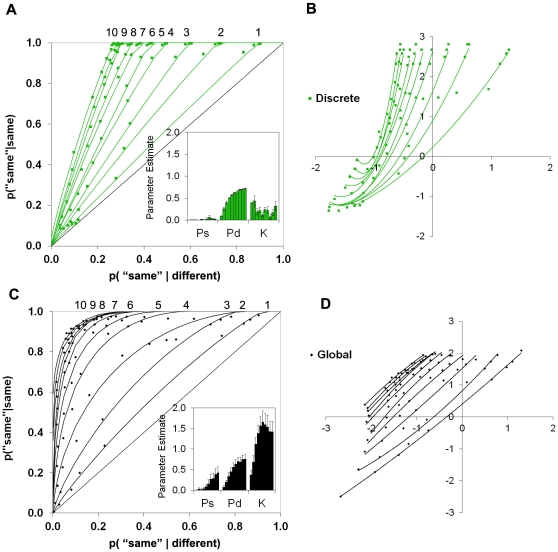
ROCs and zROCs over time.ROCs (left) and zROCs (right) were plotted for the discrete (top row) and global (bottom row) change conditions for each of the ten responses in the flicker paradigm. Average estimates of perceiving and knowing are in the insets of the ROCs; error bars show the standard error of the mean. The discrete change ROCs (A) were consistently linear, and the resulting zROCs (B) were U-shaped. The global change ROCs (C) were curvilinear with an upper x-intercept, and the zROCs (D) did not deviate from linearity.